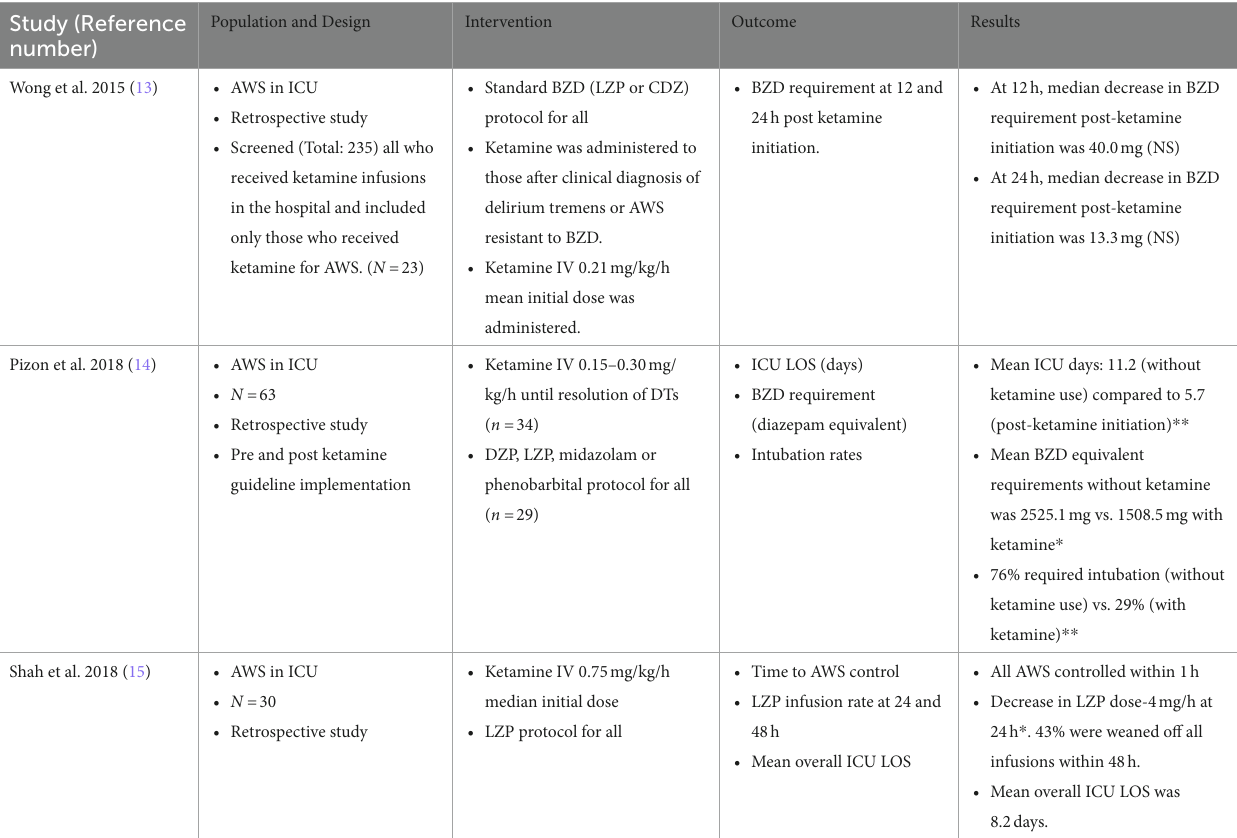
TABLE 1 Summary of current studies of ketamine for